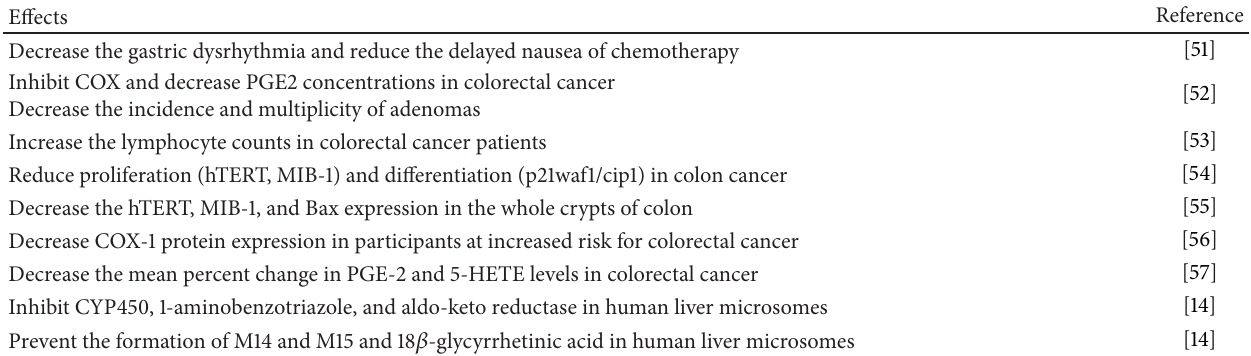
Table 3: Beneficial effects of ginger and its constituents in GI cancer